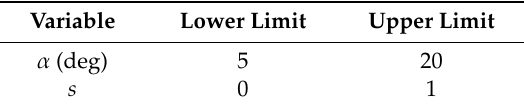
Table 1. Limits of control variables.